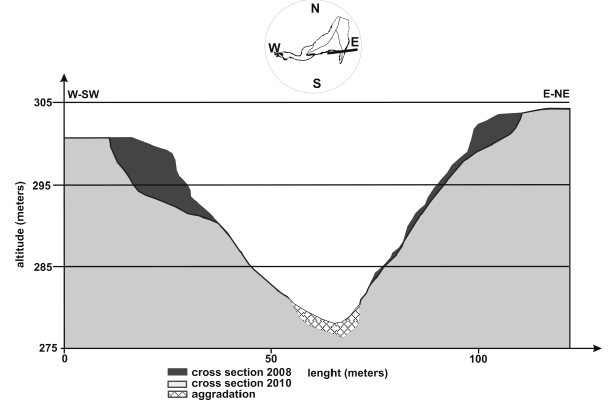
Fig. 16. Cross-section of the main gullies in the downstream